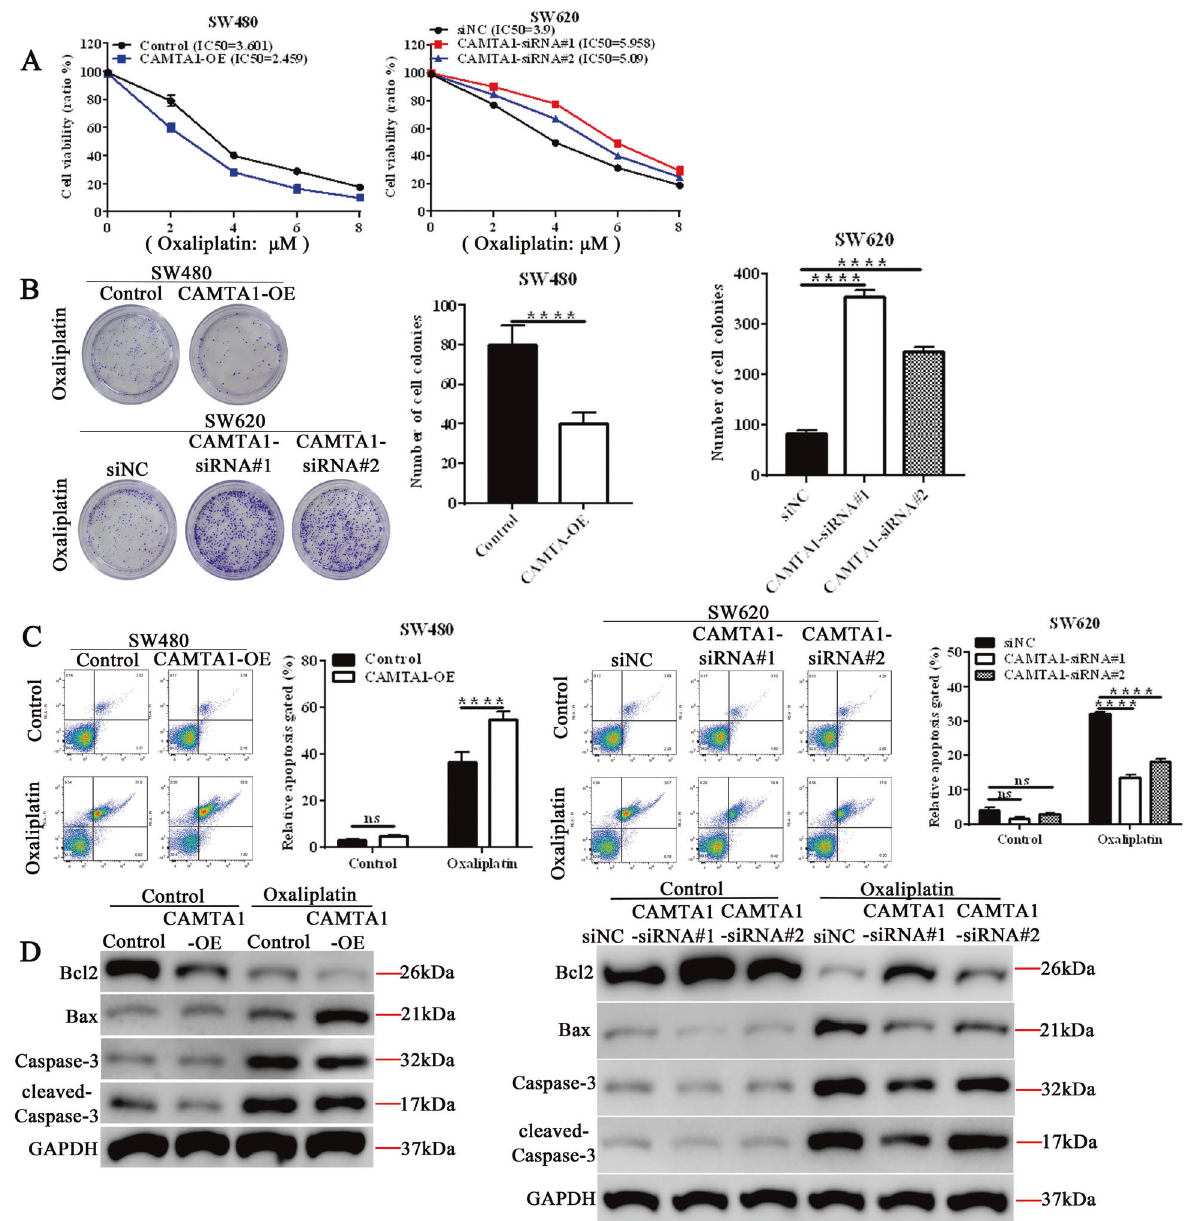
Fig. 3 Oxaliplatin promotes apoptosis in CAMTA1 -overexpressed colorectal cancer cells in vitro. A CCK8 assay results of the effects of different concentrations of oxaliplatin on the viability of CAMTA1 -overexpressed SW480 (left panel) and CAMTA1 -silenced SW620 (right panel) cells. Transfection of an empty vector served as the control in overexpression (OE) experiments. Transfection of a nontargeting siRNA (si-NC) served as the control, and two different siRNAs (siRNA#1, siRNA#2) were used for CAMTA1 knockdown in RNAi experiments. B Colony formation assay results of the effects of CAMTA1 overexpression (top panel) and knockdown (bottom panel) on the resistance of SW480 and SW620 cells to 4 μ M oxaliplatin, respectively. Graphs (right panels) summarize results from three independently-performed experiments. C Flow cytometry results of apoptosis in CAMTA1 -overexpressed SW480 (top panel) and CAMTA1 -silenced SW620 (bottom panel) cells treated with 4 μ M oxaliplatin. D Western blotting analysis of the levels of apoptosis-related proteins in CAMTA1 -overexpressed SW480 (right panel) and CAMTA1 -silenced SW620 (left panel) cells treated with 4 μ M oxaliplatin. GAPDH served as the internal control for data normalization. Data are presented as the mean ± S.E.M., n = 3. ** P < 0.01; **** P < 0.0001 by one-way ANOVA, followed by Tukey ’ s HSD CAMTA1 directly interacts with NFATc4 and PPP3CA and Flow cytometry detection of cell apoptosis found that after upregulates NFATc4 expression in colorectal cancer cells oxaliplatin treatment of SW480 cells, the overexpression of in vitro NFATc4 reduced cell apoptosis, while the overexpression of PPP3CA is one of the genes encoding calmodulin-binding subunit CAMTA1 induced apoptosis of NFATc4 overexpressing cells. In calcineurin A, which regulates the Cn/NFAT signaling pathway. SW620 cells, knockdown of NFATc4 increased apoptosis, and PPP3CA regulates the phosphorylation of NFATc4. In order to knockdown of CAMTA1 rescued this change (Fig. 5D). In further clarify the mechanism of action of CAMTA1/NFATc4 in conclusion, the negative regulation of NFATc4 by CAMTA1 is oxaliplatin resistance in colorectal cancer, we analyzed the involved in the oxaliplatin resistance of colorectal cancer.